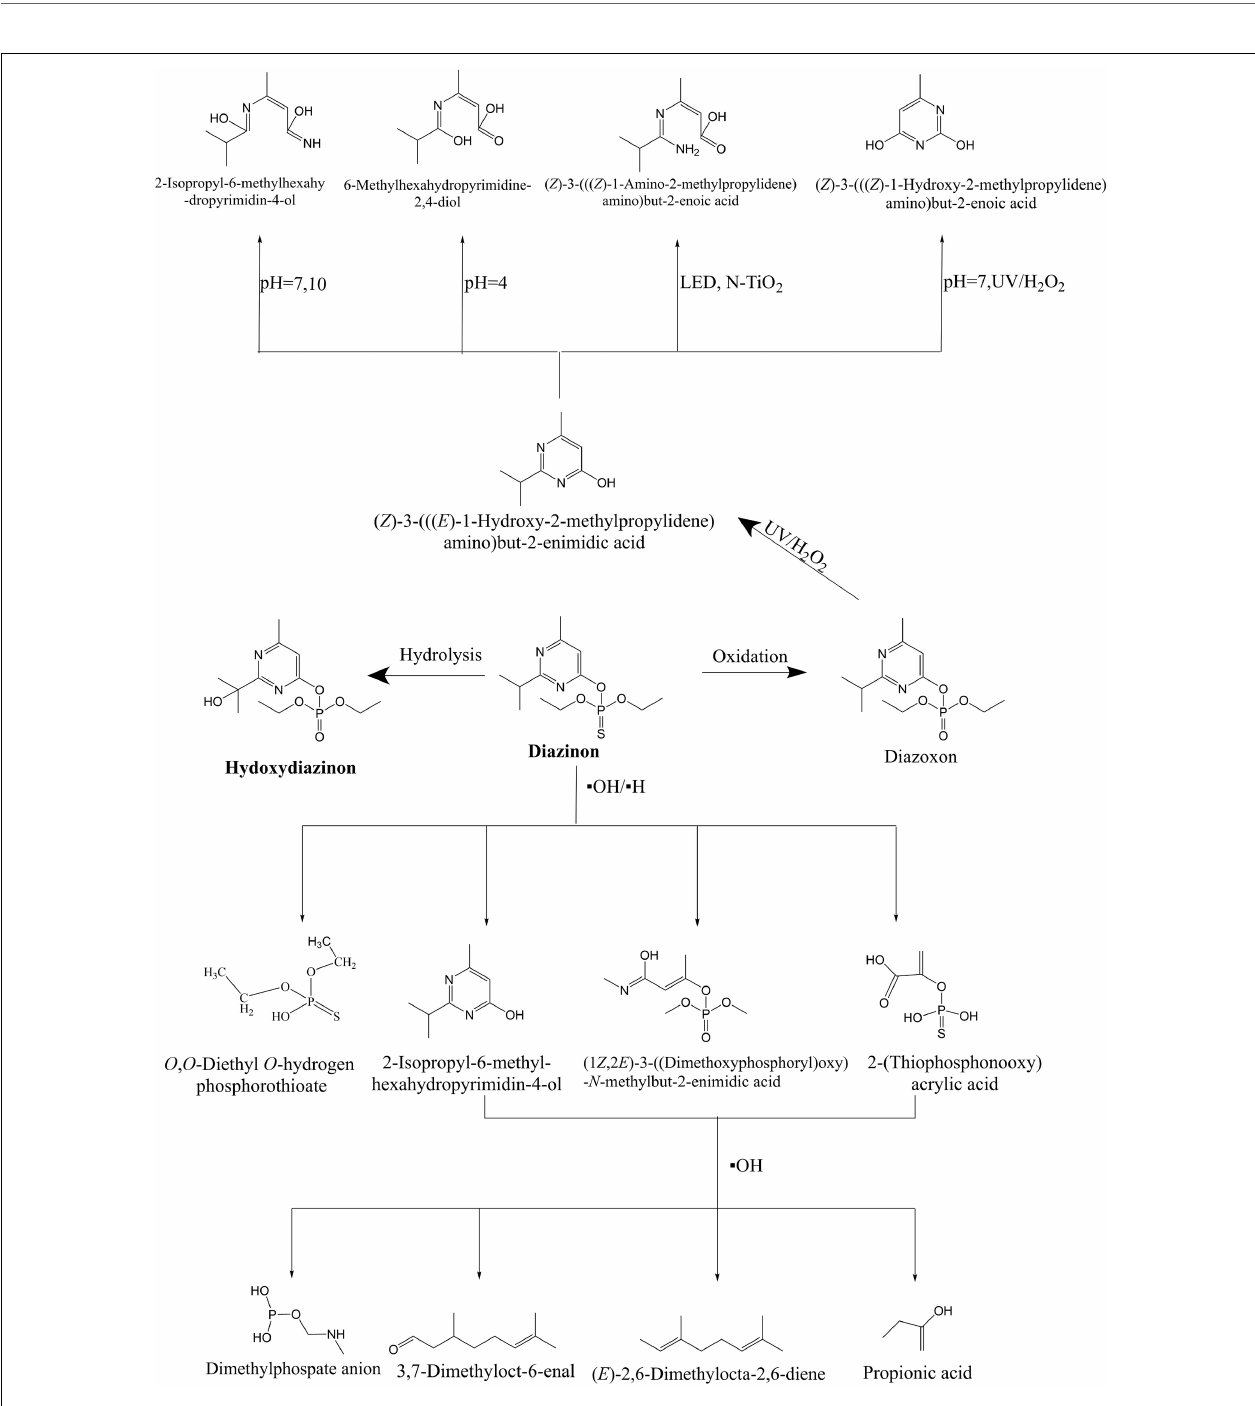
FIGURE 2 | Proposed physico-chemical degradation pathways of diazinon (Arief et al., 2015; ˇColovi´c et al., 2015; Malakootian et al., 2020). The thick black arrows point to the major degradation products.